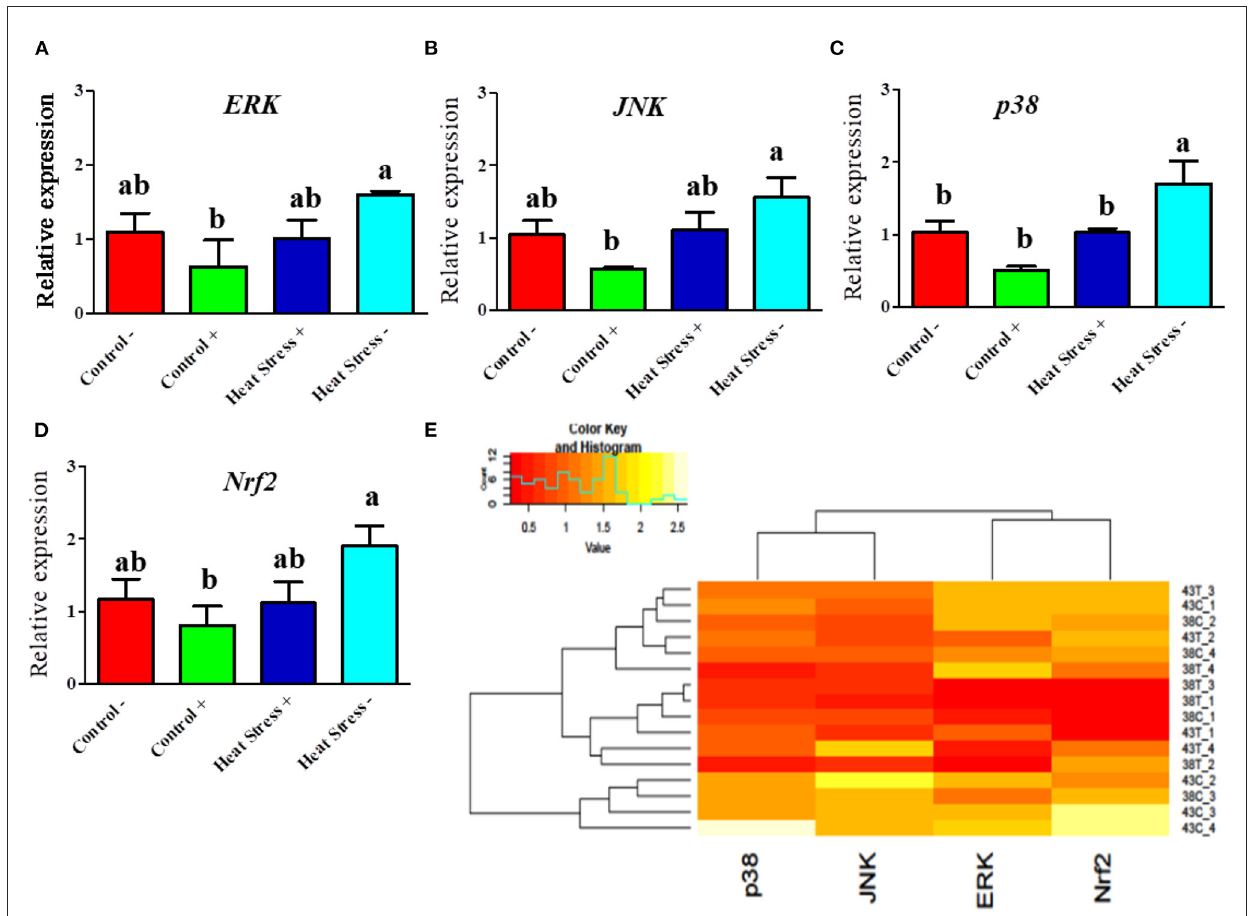
FIGURE5 Effects of COPA3 on heat stressed fibroblasts’ MAPK/ERK-Nrf2 related gene expression. (A–D) Relative mRNA expression levels of the genes of extracellular signal-regulated kinases, jun N-terminal kinase, p38 mitogen-activated protein kinases, and nuclear factor erythroid 2–related factor 2 involved in the MAPK/ERK-Nrf2 obtained by RT-qPCR; data represent mean ± SE; a,b different letters indicate significant difference in different groups ( P < 0.05). (E) Cluster analysis of the mRNA expression corresponding to the MAPK/ERK-Nrf2 components. Groups are distinguished by temperatures and COPA3 treatment, that is, fibroblasts at 38 ◦ C (Control- group), 38 ◦ C with COPA3 treatment (Control + group), 43 ◦ C with COPA3 treatment (Heat Stress + group), and 43 ◦ C temperature (Heat Stress- group). Each experiment was conducted in four biological replicates ( n =